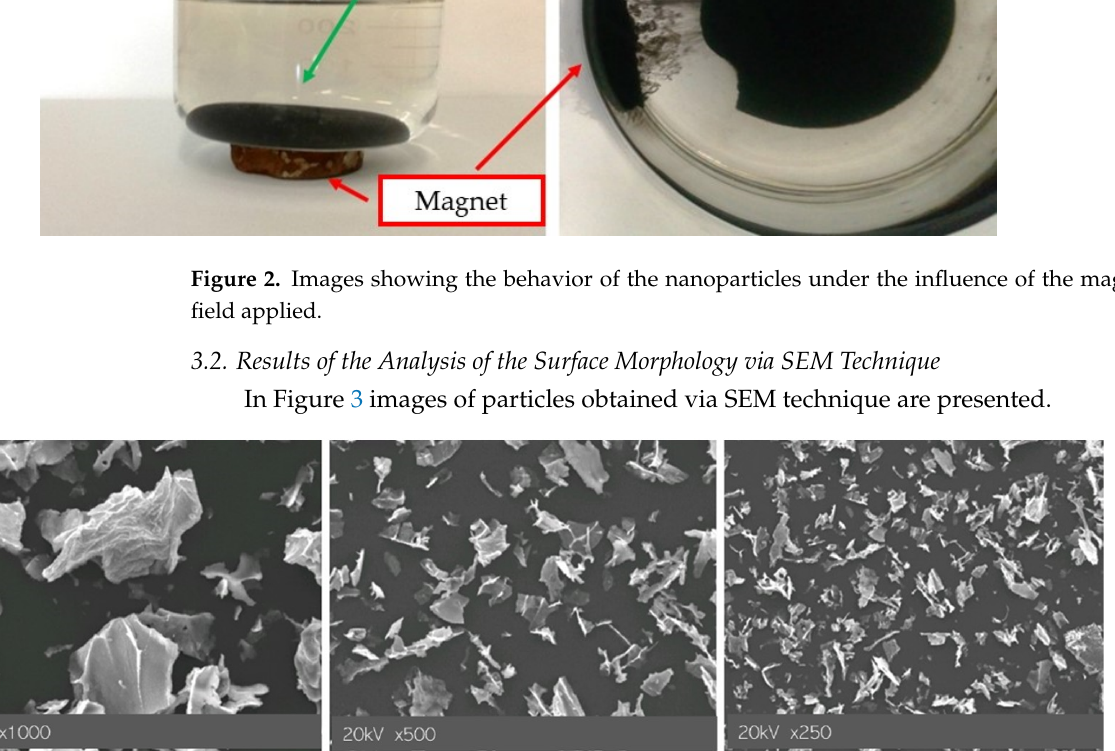
Figure 2. Images showing the behavior of the nanoparticles under the influence of the magnetic field applied.